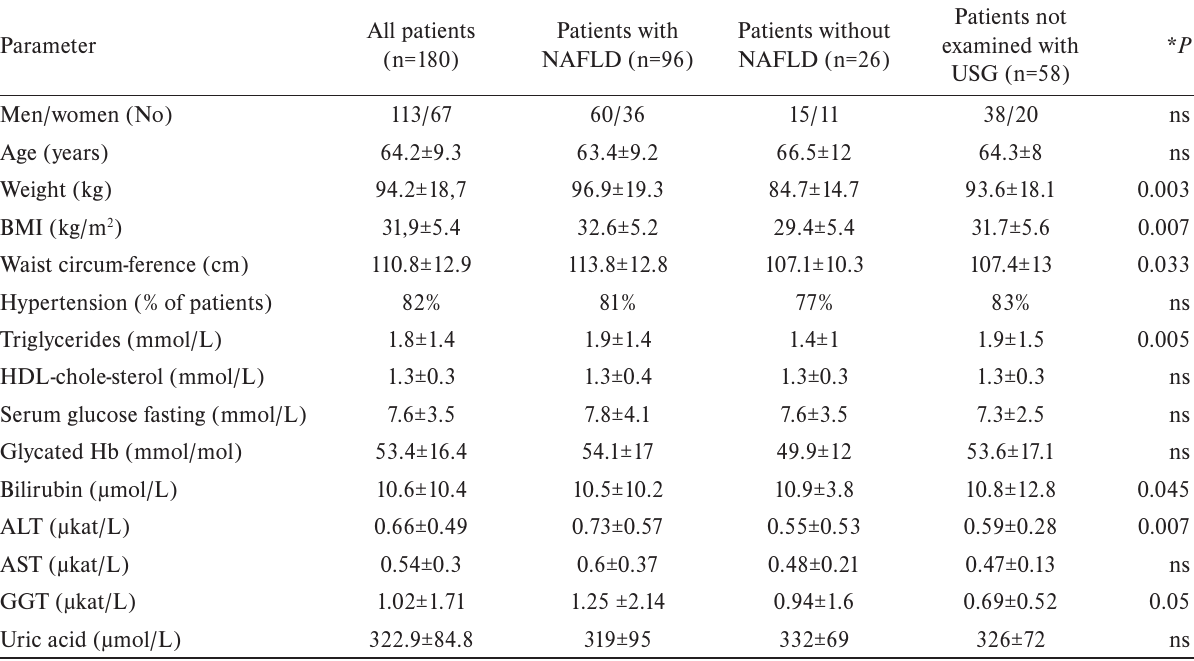
Table 2. Demographic and laboratory parameters in the study cohort.